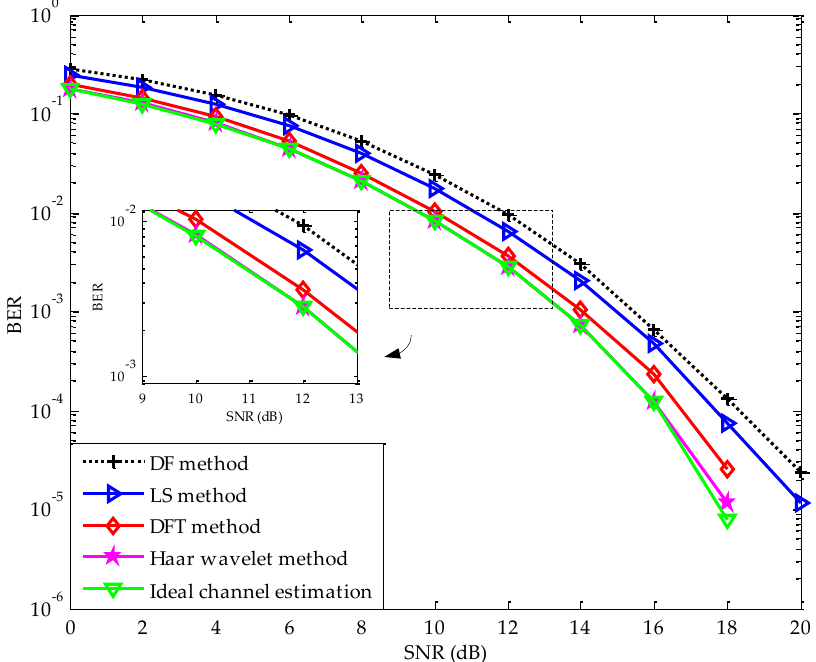
Figure 6. Bit error rate (BER) performance of quadrature phase shift keying (QPSK) modulated CP-OFDM and wavelet-OFDM systems under CDT1 channel.